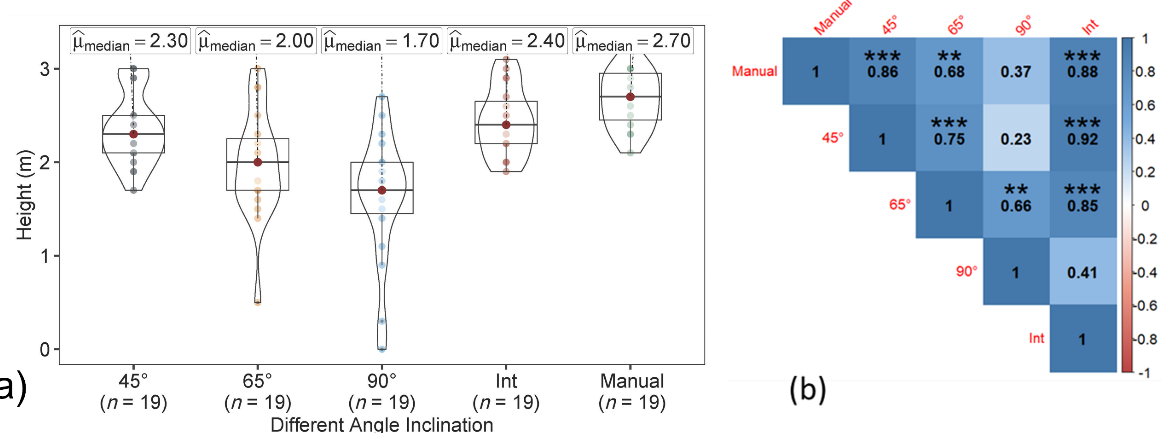
Figure 7. ( a ) Violin box plot showing the tree height range (m) and ( b ) correlation matrix showing the correlation between the ground reference data and estimated T2-based tree height at individual angles (45°, 65°, and 90°) and the integration of nadir and oblique images. Significant probability level: * 0.05, ** 0.01, and *** 0.001.